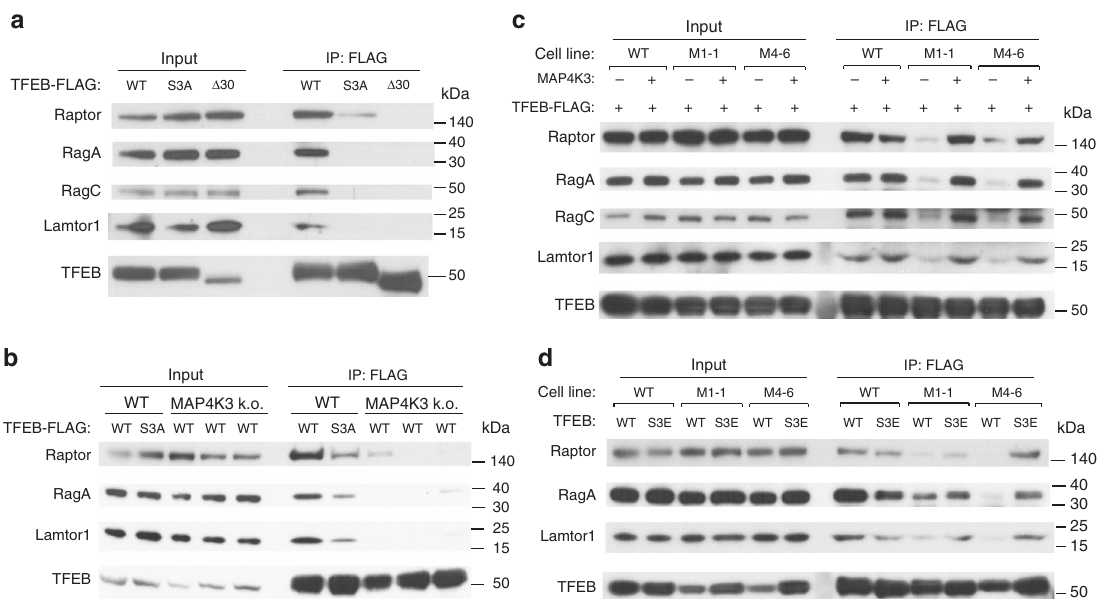
Fig. 4 MAP4K3 and TFEB serine 3 phosphorylation are required for interaction of TFEB with the mTORC1-Rag GTPase complex. a TFEB serine 3 is required for its interaction with the mTORC1-Rag GTPase complex. HEK293A cells were transfected with either WT TFEB, TFEB-S3A, or TFEB- Δ 30, each FLAG- tagged, and cell lysates and FLAG immunoprecipitates were subjected to immunoblotting. b MAP4K3 is required for TFEB interaction with the mTORC1- Rag GTPase complex. WT HEK293A cells and MAP4K3 k.o. cells were transfected with either WT TFEB or TFEB-S3A, each FLAG-tagged, and cell lysates and FLAG immunoprecipitates were subjected to immunoblotting. c TFEB interaction with the mTORC1-Rag GTPase complex is rescued by MAP4K3 in MAP4K3 k.o. cells. WT HEK293A cells, M1-1 MAP4K3 k.o. cells, and M4-6 MAP4K3 k.o. cells were transfected with TFEB-FLAG alone, or co-transfected with TFEB-FLAG and MAP4K3, and cell lysates and FLAG immunoprecipitates were subjected to immunoblotting. d TFEB phosphomimetic S3E enhances TFEB interaction with the mTORC1-Rag GTPase complex in MAP4K3 k.o. cells. WT HEK293A cells, M1-1 MAP4K3 k.o. cells, and M4-6 MAP4K3 k.o. cells were transfected with either WT TFEB or TFEB-S3E, each FLAG-tagged, and cell lysates and FLAG immunoprecipitates were subjected to